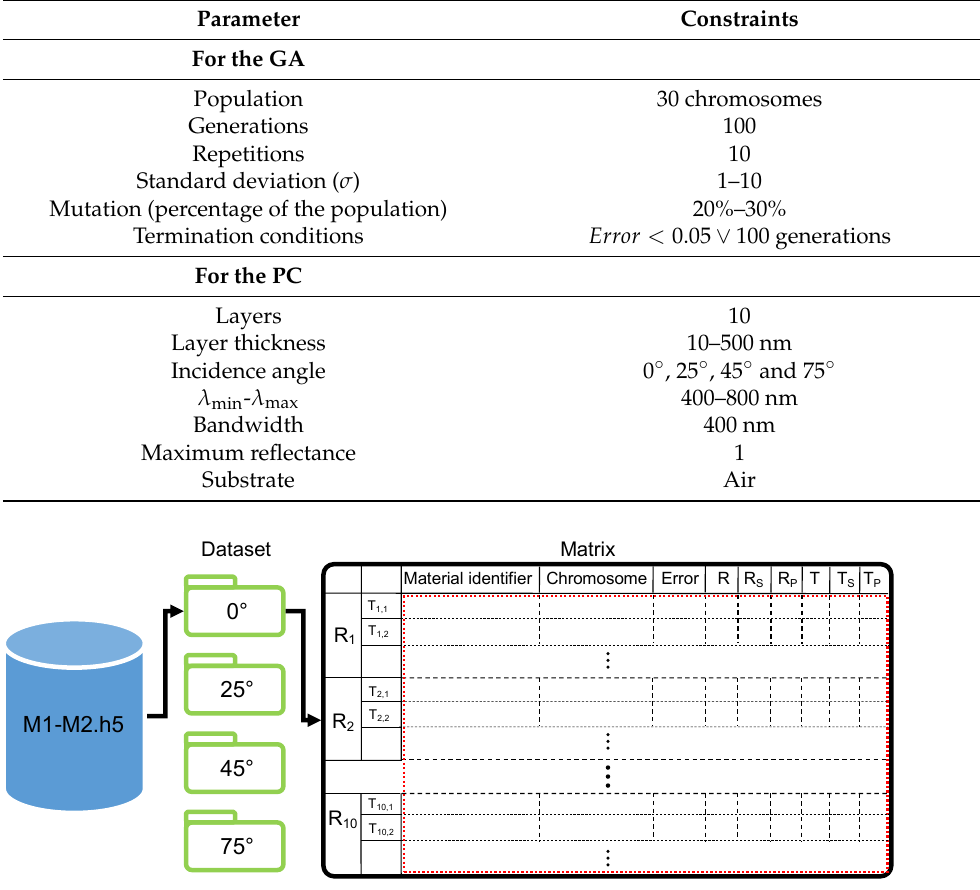
Figure 3. Structure of the h5 file The file contains indicators for the materials used, the thickness values of the photonic crystal series, and reflectance and transmittance for polarized (S and P) and unpolarized